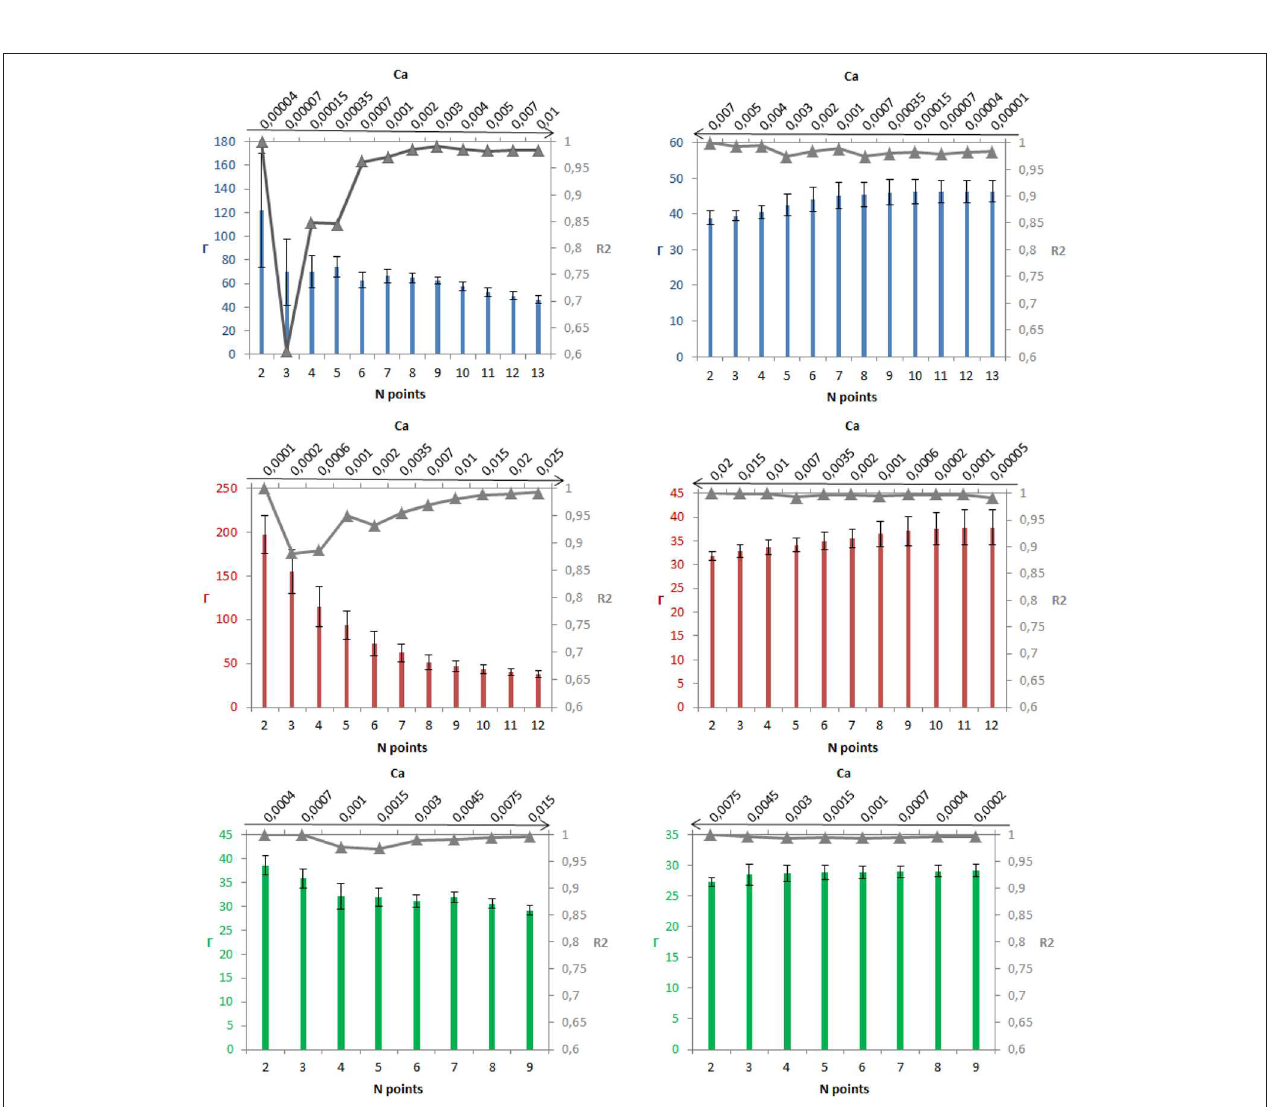
FIGURE 7 | Sensitivity of Ŵ for PEG1450 (blue), PEG3350 (red), and PEG10000 (green): from the lowest Ca to the highest one (left) ; from the highest Ca to the lowest one (right) .